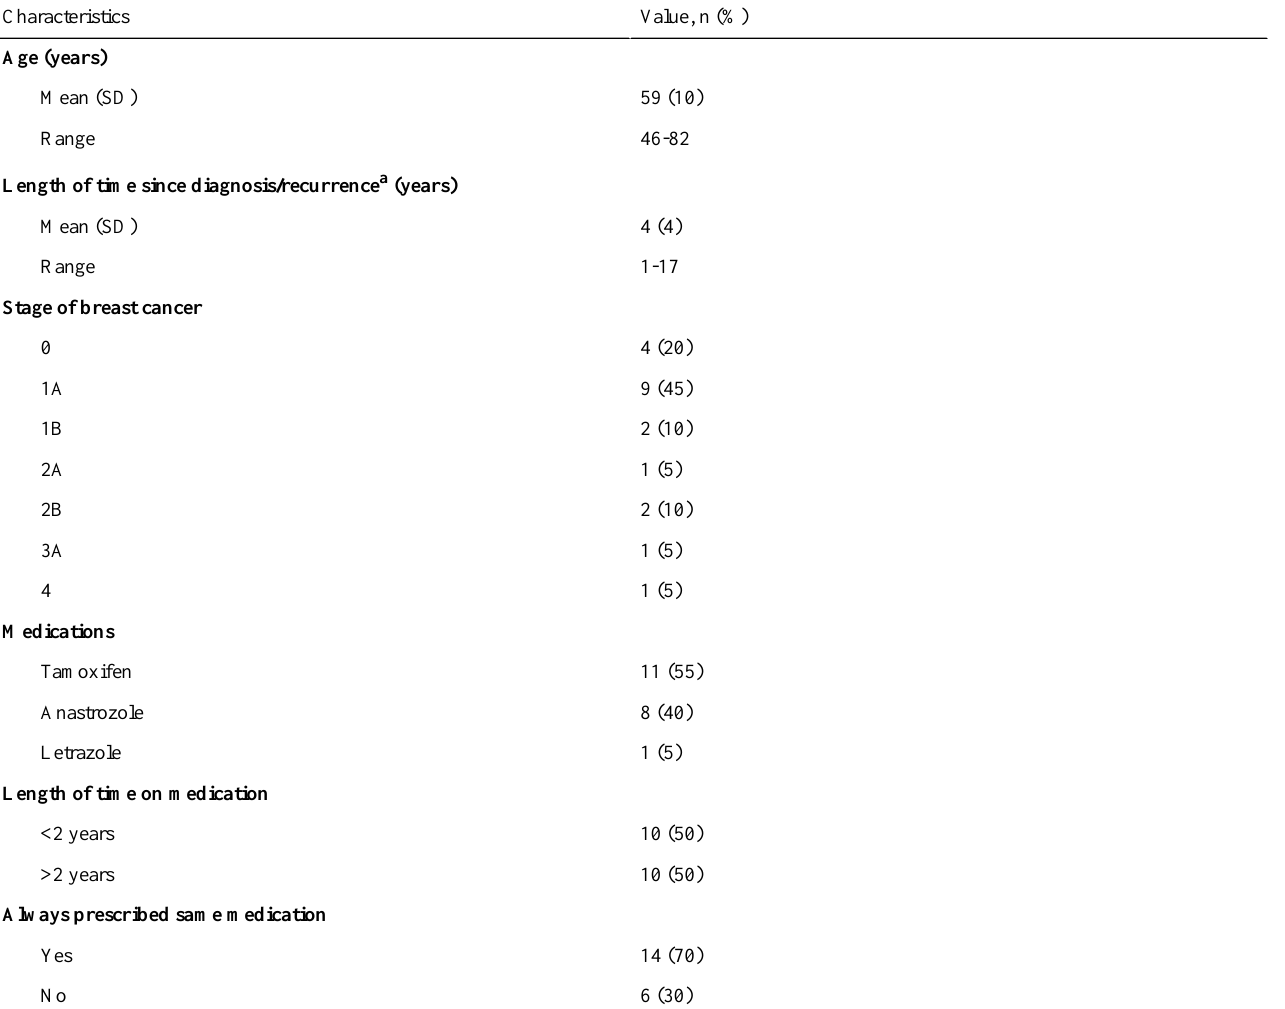
Table 1. Participant characteristics.